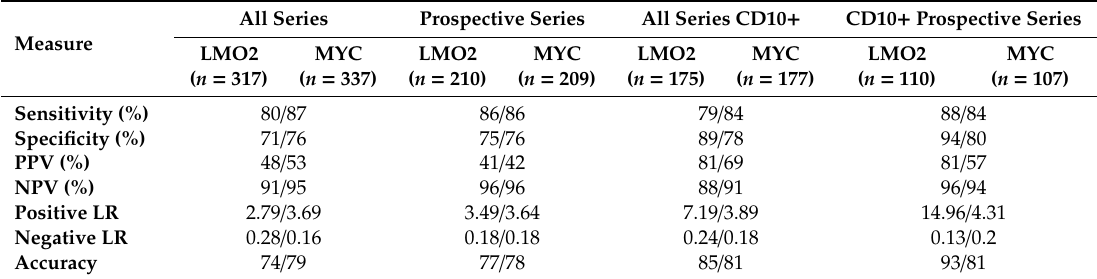
Table 2. Statistic measures of the performance of LMO2 and MYC compared with the presence of MYC gene rearrangements as gold standard in